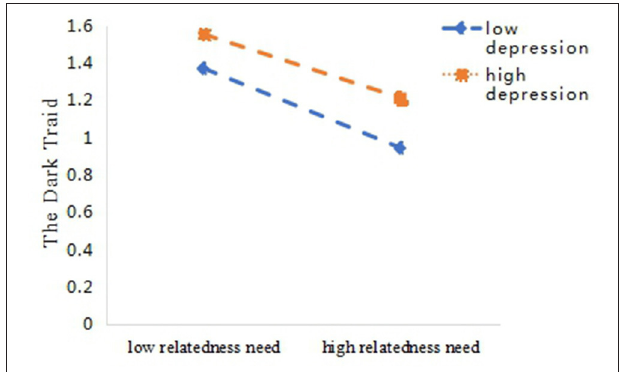
FIGURE 3 | Depression moderates relatedness need satisfaction and the dark